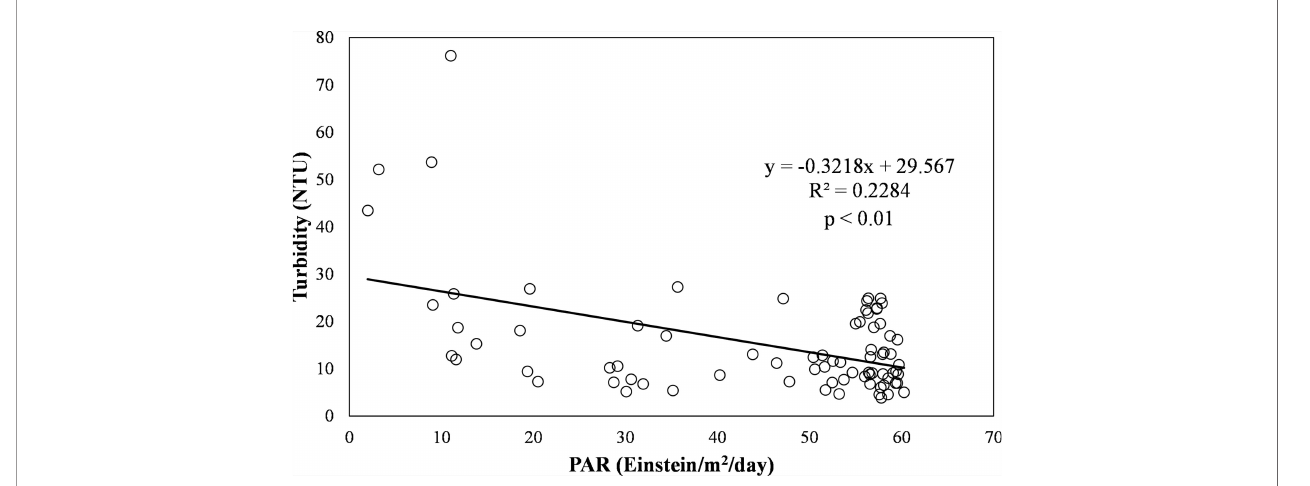
FIGURE 7 | The relationship between turbidity and PAR (R 2 = 0.2284, p<0.01) from July 26 to August